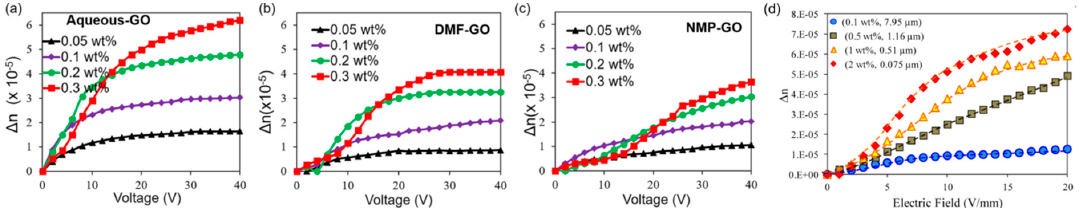
Figure 13. The induced birefringence of GO dispersions as a function of voltage for three different solvents: water ( a ), DMF ( b ) and NMP ( c ). Reprinted from Ahmad et al. [42], with the permission of AIP Publishing. ( d ) The field induced birefringence of different dispersions with different average flake sizes and concentrations as a function of electric field. Reprinted with permission from ref. [39], The Optical Society.